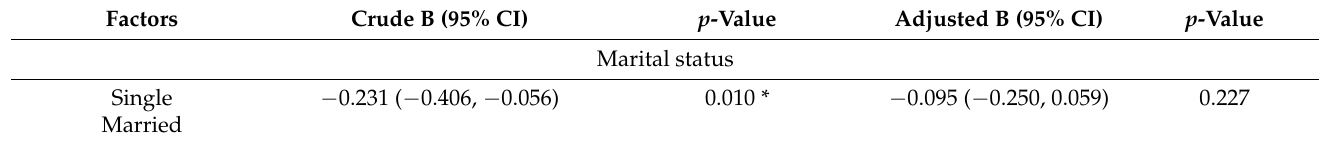
Table 5. Multivariable analysis on factors associated with BRS-M total score (n =